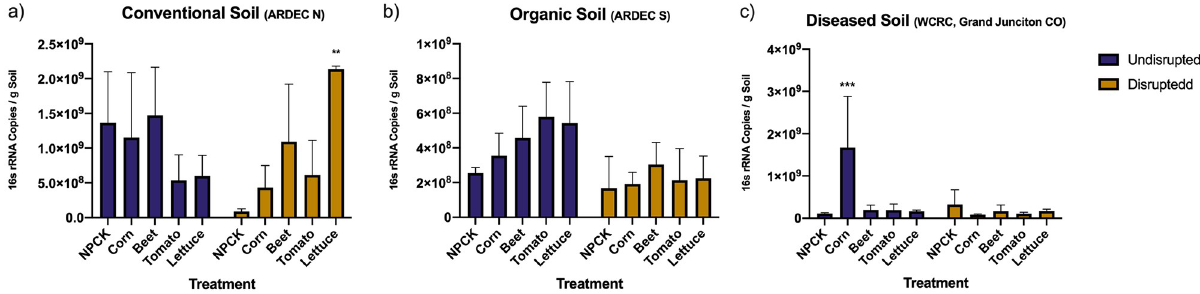
Fig 2. Mean 16s rRNA copies per gram of fresh weight of each soil (n = 3 per crop per soil treatment, ± standard deviation). (a) 16s rRNA copies resulting after crop growth in organic soil (b) 16s rRNA copies resulting after crop growth in conventional soil (c) 16s rRNA copies resulting after crop growth in diseased soil. Purple or yellow bars represent the mean number of 16s rRNA copies for each crop grown in undisrupted or disrupted soils, respectively. Significant differences in 16s rRNA copies between the NPCKs and crop treatments are denoted by “ � ”. Figure created using GraphPad’s Prism (Vers.